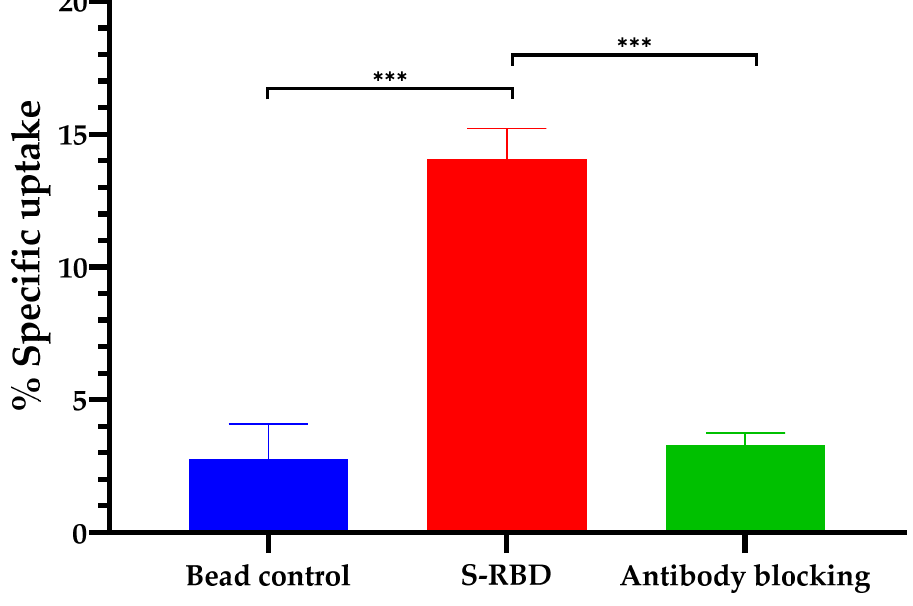
Figure 7. The specific uptake of [ 131 I]-IgY anti-RBD spike SARS-CoV-2. Significant differences among the three arms are indicated as *** p <